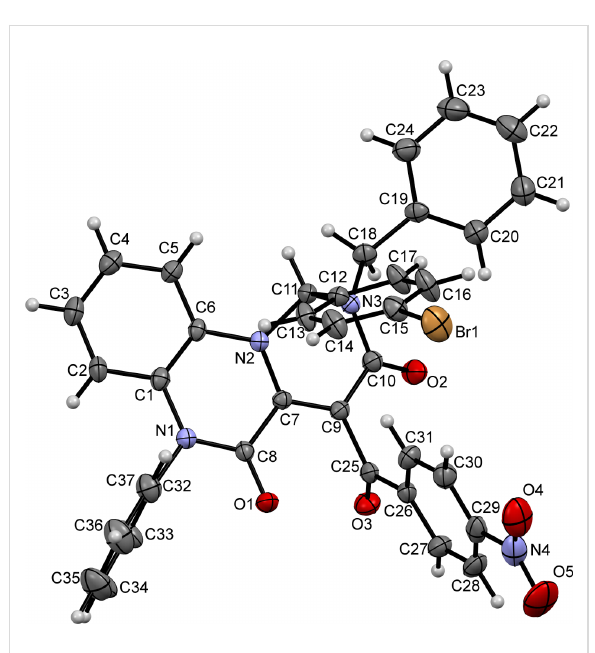
Figure 6: ORTEP drawing of compound 3g (CCDC 1834011) showing thermal ellipsoids at the 30% probability level.